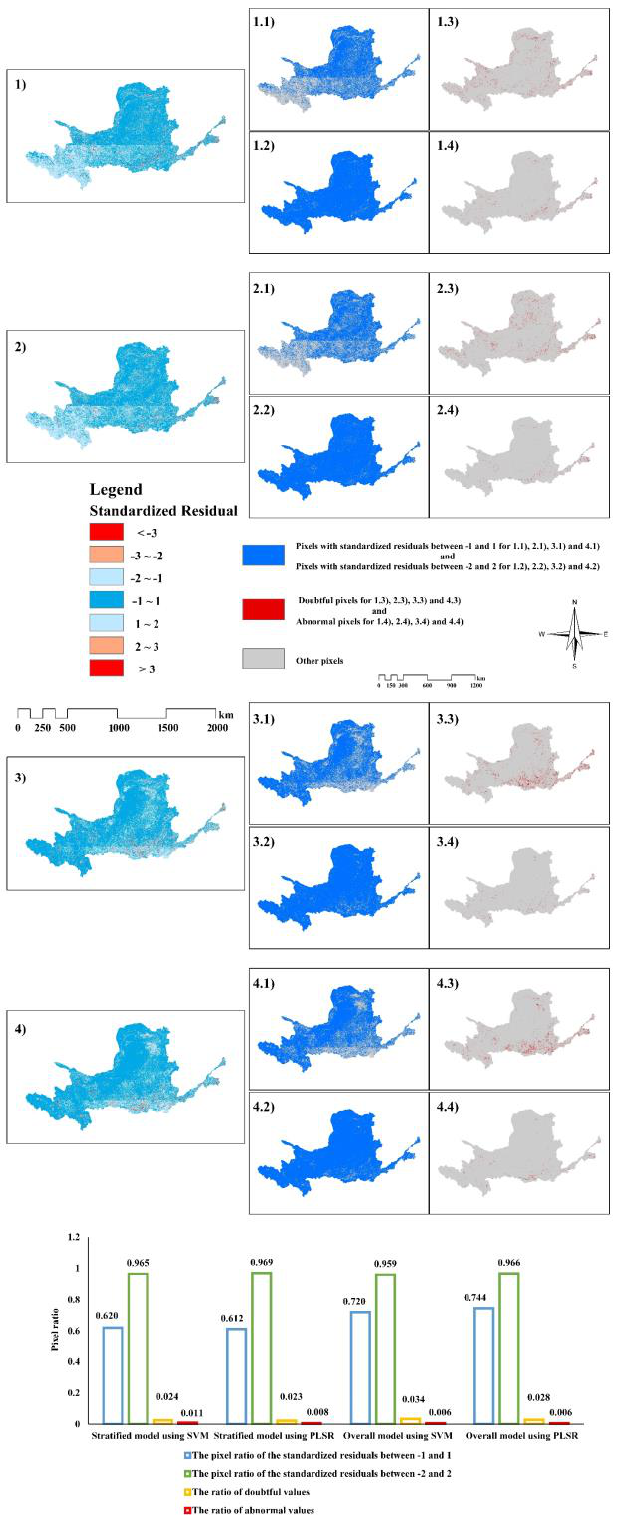
Figure 10. The spatial distribution of the standardized residual of the four estimated results. Notes: 1, 2, 3, and 4 corresponded to the stratified support vector machine (SVM), stratified partial least squares regression (PLSR), overall SVM, and overall PLSR methods, respectively; in addition, x.1, x.2, x.3, and x.4 represent the spatial distribution of the standardized residuals between − 1 and 1, between − 2 and 2, doubtful pixels, and abnormal pixels, respectively, for the above four methods.